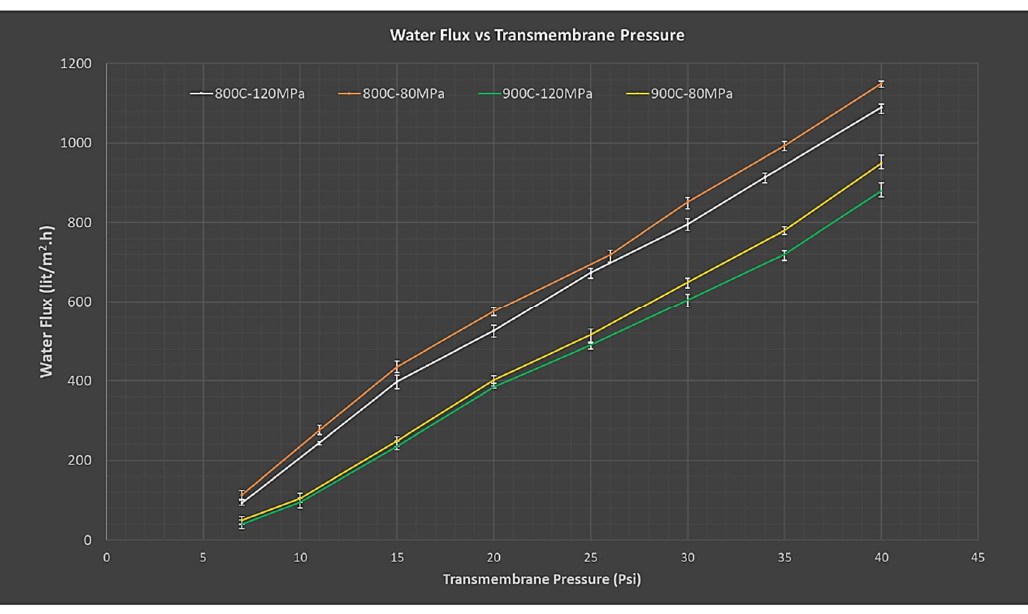
Figure 12. Water permeate flux as a function of initial compaction load and sintering temperatures.